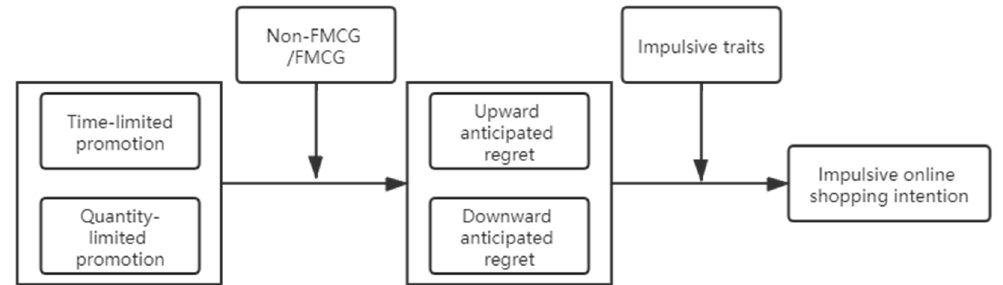
Figure 2. Research Figure 2. Research model.